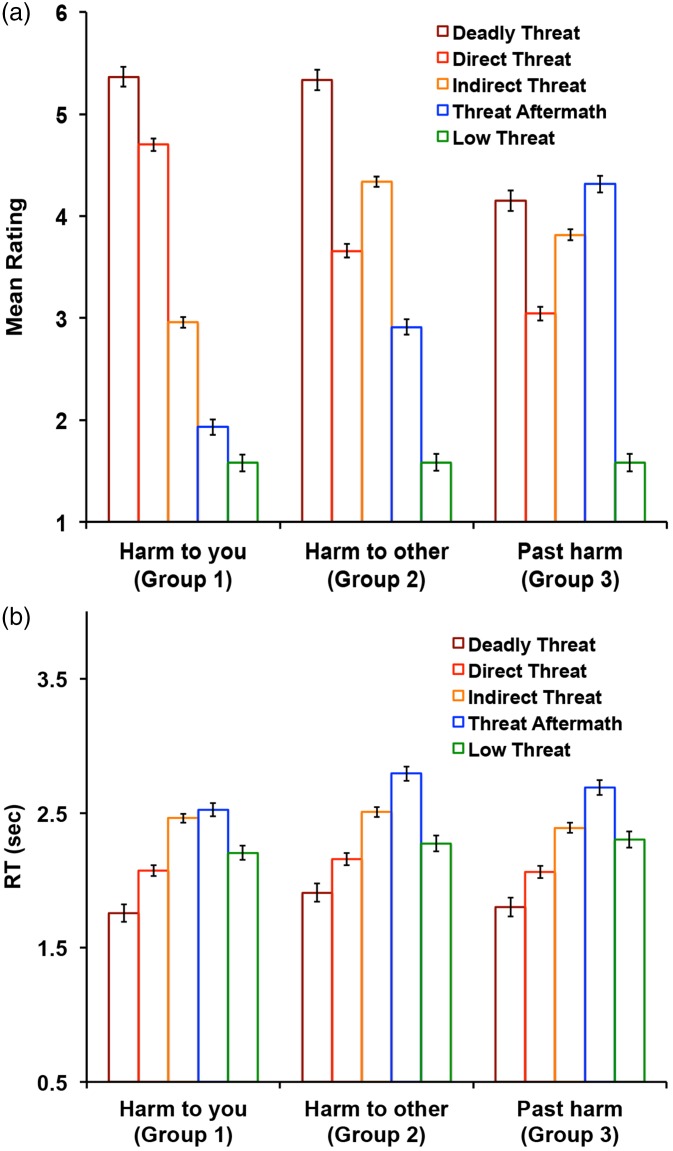
Study 1 results. (a) Results of the scene ratings. The three panels show the results from the three rating groups. Participants in Group 1 (left panel) were asked to rate all images in terms of potential harm to them personally; participants in Group 2 (middle panel) were asked to rate all images in terms of potential harm to someone else; participants in Group 3 (right panel) were asked to rate all images in terms of past harm, but no present harm. 500 images were presented in a randomized mixed sequence. (b) Results of the RT. The error bars indicate standard error of the mean.